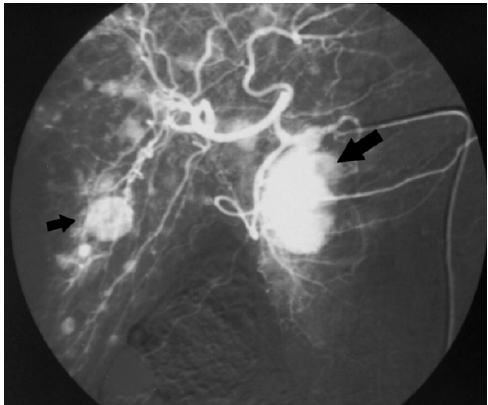
Figure 1. Angiography of the celiac trunk showing a mass in the pancreatic head (big arrow) and multiple liver metastases (small arrow) in a patient with carcinoid syndrome (case n.1).